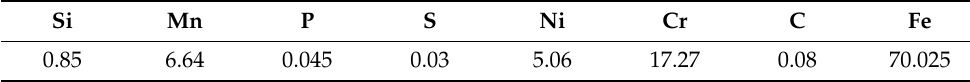
Table 3. Chemical composition of AISI 201 (wt.%).